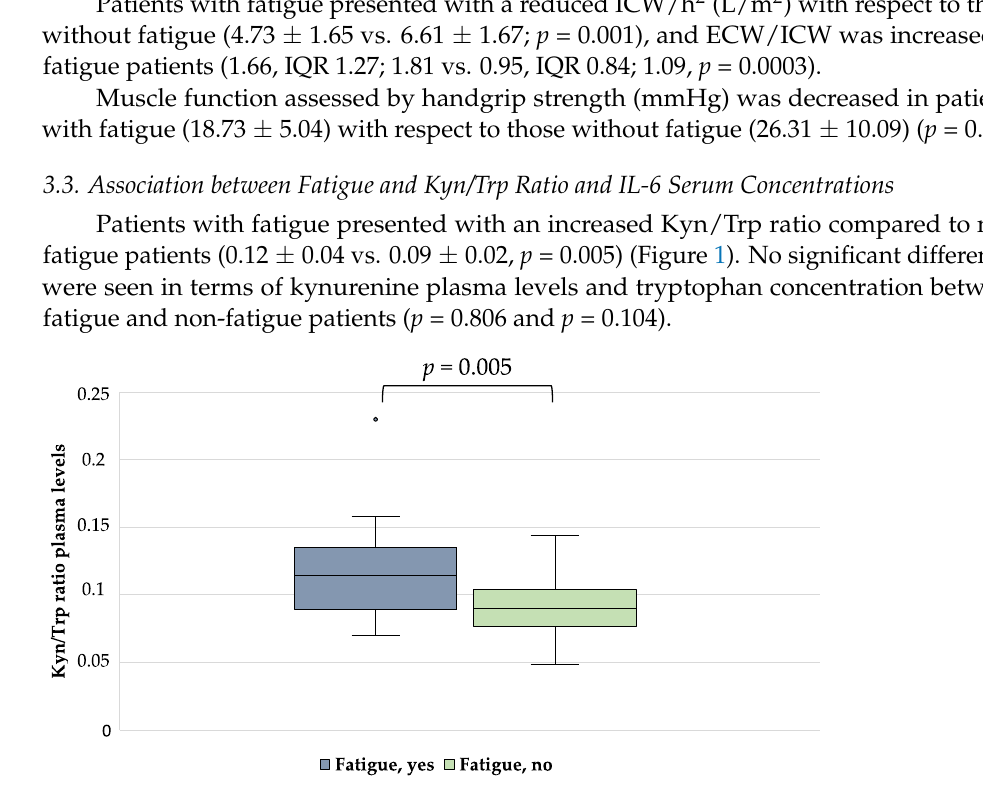
Figure 1. Kyn/Trp ratio in plasma of HD patients with and without fatigue.